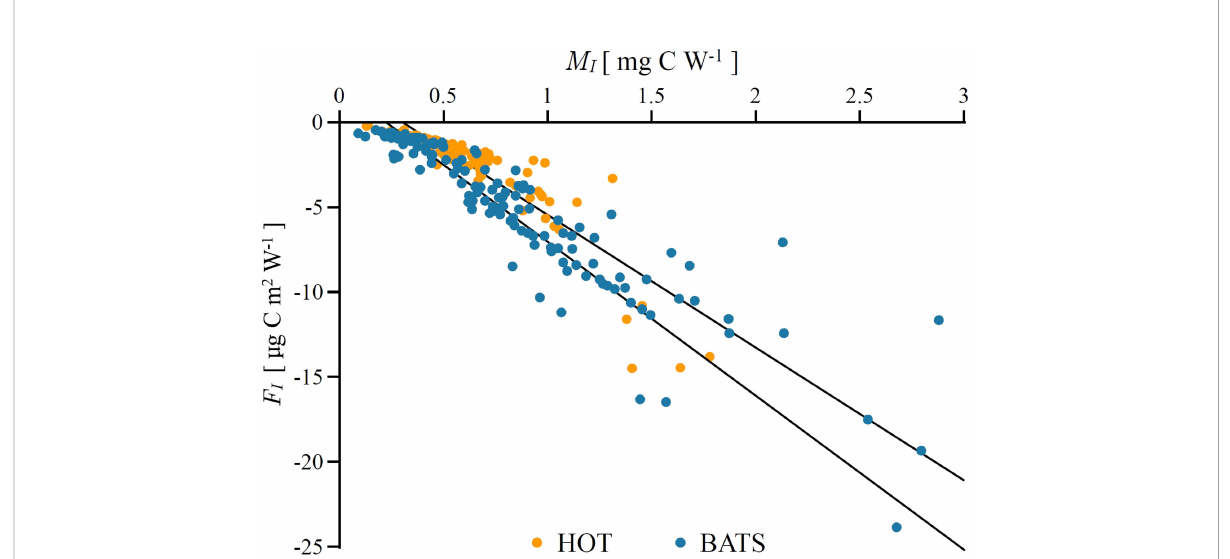
FIGURE 4 Marginal watercolumn production M I and watercolumn production fragility F I , as de fi ned in (11) and (19), estimated from in situ data at Bermuda Atlantic Time-Series Study (blue dots) and Hawaii Ocean Time Series (orange dots). Black lines give a linear fi t of F I as a function of M I for each station. All points are fragile implying variability in surface irradiance acts to suppresses biomass and